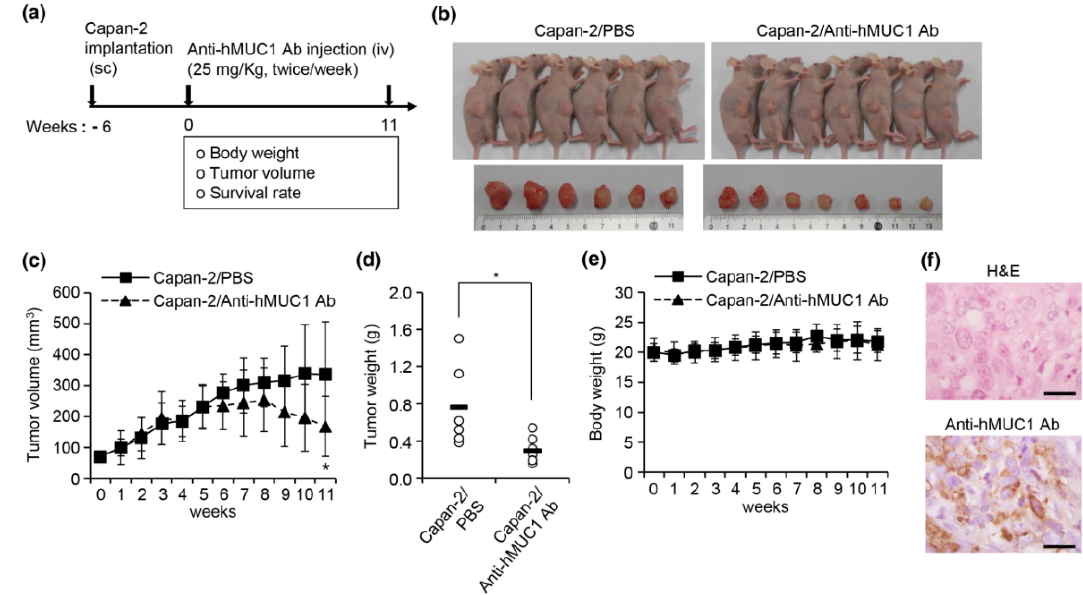
Figure 5. Effect of anti ‐ hMUC1 monoclonal antibody on pancreatic tumor growth in a xenograft mouse model. A mouse xenograft model was established by injection of Capan-2 cells in BALB/c nu/nu mice. Once the tumors reached 80 mm 3 in volumes, PBS or anti-hMUC1 monoclonal antibody (25 mg/Kg) was intravenously injected into mice. Tumor growth was observed for 11 weeks ( n = 8). ( a ) Experimental schedule. ( b ) Images of mice bearing tumors and isolated tumors from mice. ( c ) Tumor volumes and ( d ) individual tumor weights for each treatment group. ( e ) Individual body weights for each treatment group. ( f ) Histology of tumor tissue was observed by staining with hematoxylin and eosin (H&E, upper panel). Immunohistochemical analysis of tumor tissue was performed with anti-hMUC1 monoclonal antibody (lower panel). Scale bars, 100 µ m. * p < 0.05 .